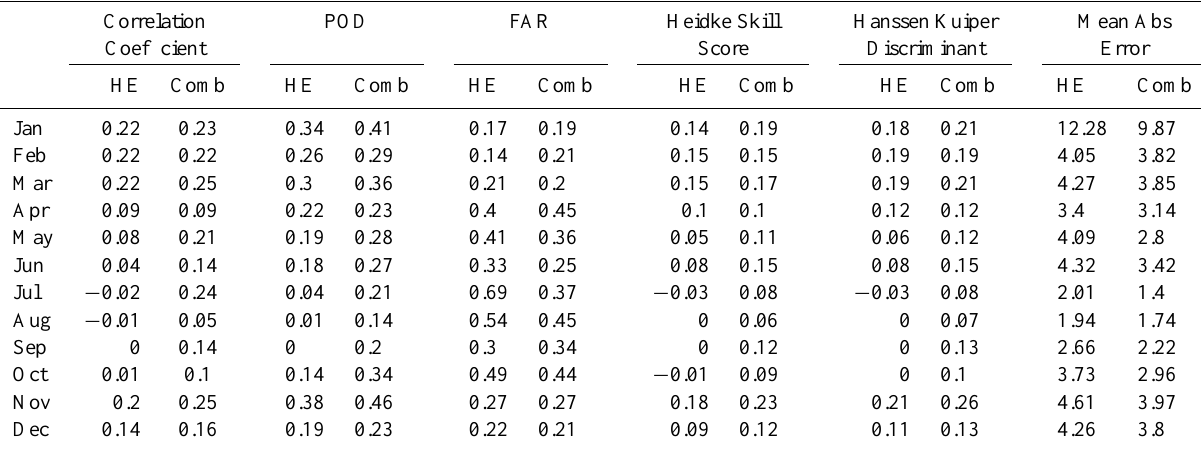
Table 2. Statistical evaluation of HE and COMB in 2008.